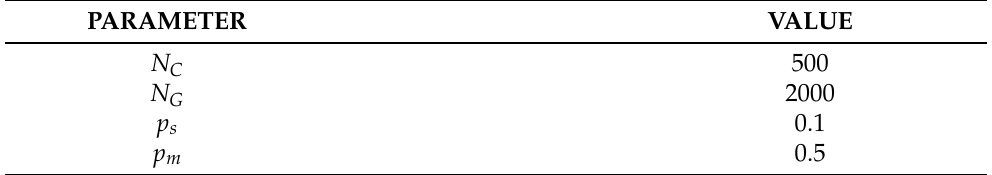
Figure 3. Comparison of average classification error for RBF and artificial neural network for different number of weights. Table 1. Experimental parameters.